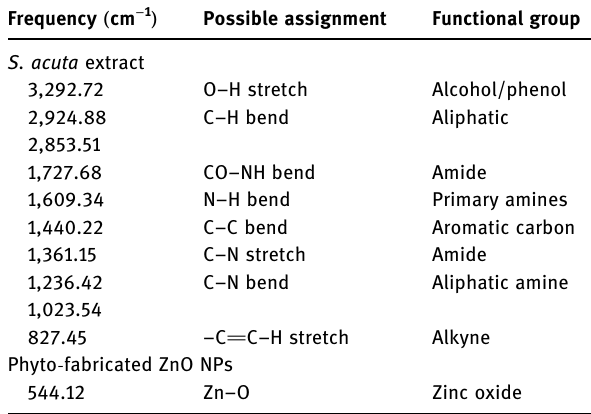
Table A1: FT - IR spectra with possible assignments Table A2: Antioxidant potentiality of phyto